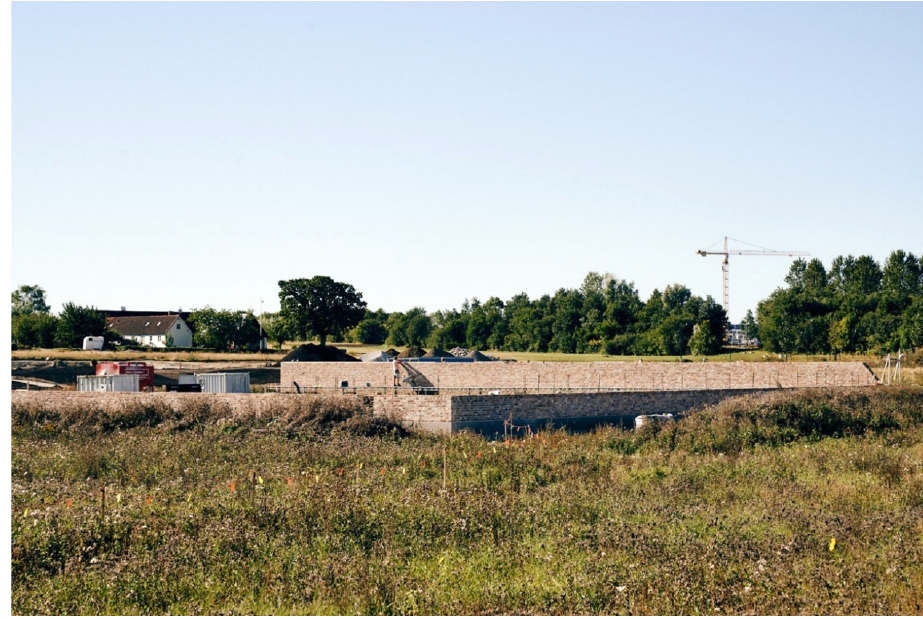
Figure 6. Construction of Hage developed by Brendeland & Kristoffersen. Source: Peter Westrup. Urban Planning, 2021, Volume 6, Issue 1, Pages